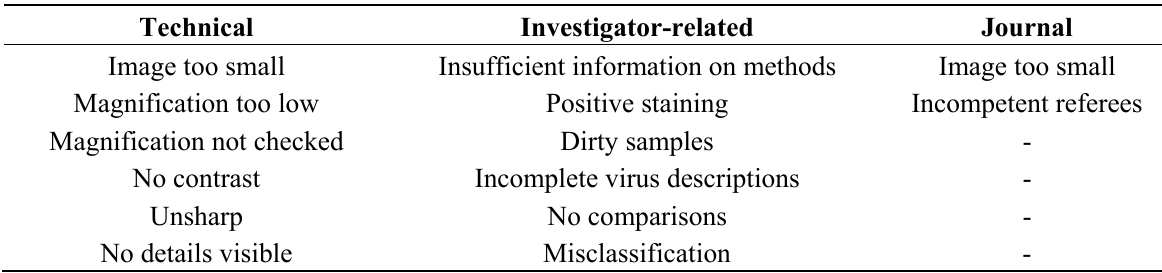
Table 4. Some reasons for poor